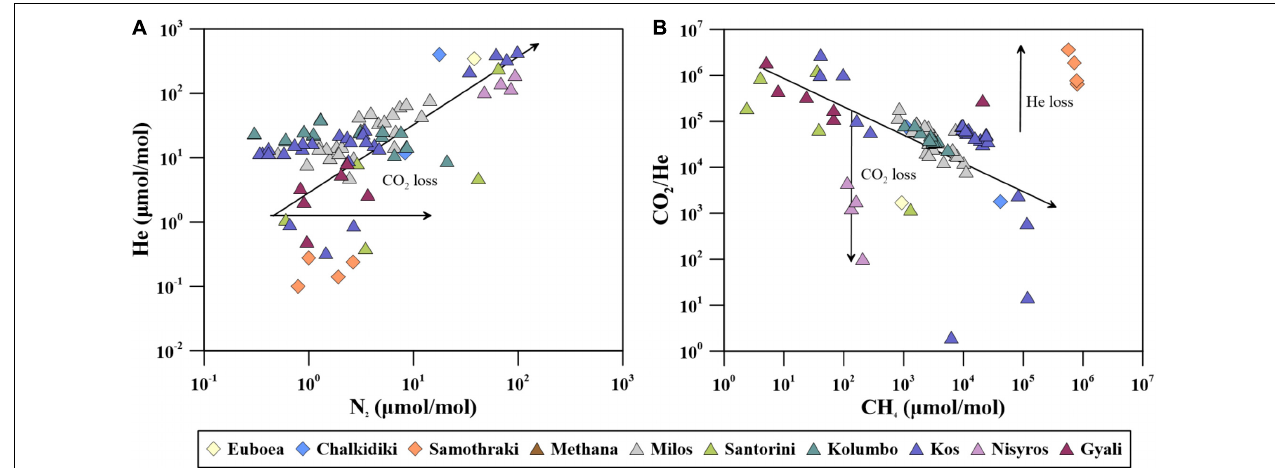
FIGURE 8 | Binary plot of (A) He-N 2 and (B) CO 2 /He-CH 4 . Processes impacting the gases are drawn with an arrow. Literature data from Chiodini et al. (1998), Shimizu et al. (2005), Kyriakopoulos (2010), Carey et al. (2013), Tassi et al. (2013), Rizzo et al. (2016, 2019), Daskalopoulou et al. (2018a,b, 2019b, 2021a), and Tarchini et al.